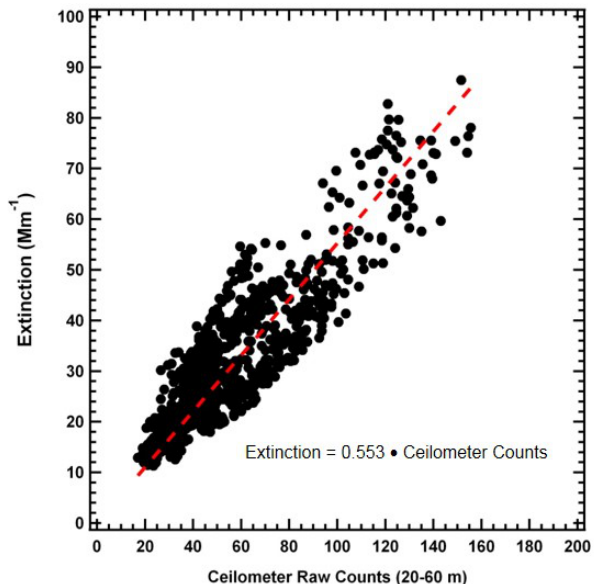
Fig. 1. Shown here is the extinction coefficient, derived from the nephelometer and PSAP measurements as a function of the raw backscattering, range-corrected counts from the ceilometer aver- aged between 20 and 60m. Each point represents a ten minute av-